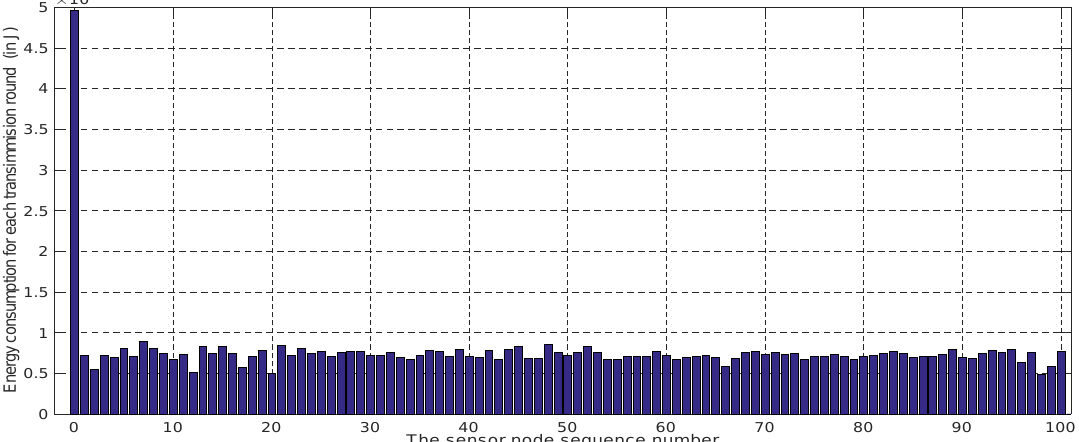
Figure 3. Averages of sensor nodes’ energy consumption for one transmission round in the dynamic hierarchical protocol based on combinatorial optimization (DHCO)